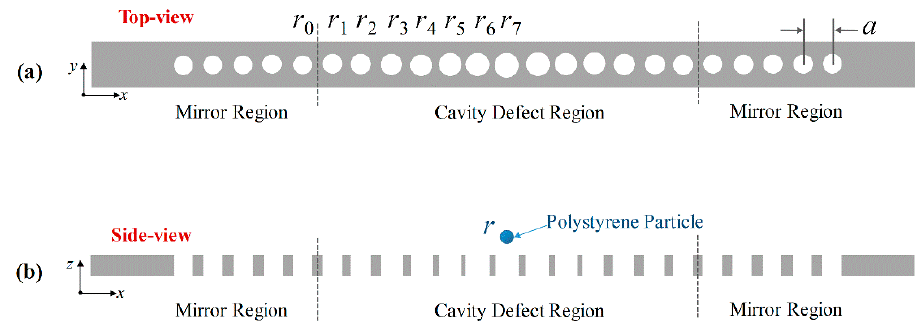
Figure 1. ( a ) Top-view and ( b ) Side-view of the structure of the larger-center-hole nanobeam photonic crystal cavity, above which a polystyrene particle is introduced. The position of the polystyrene particle deviates from the center of the largest hole of the cavity in the x direction is denoted as ∆ x . The distance between the center of the polystyrene particle and the top surface of the nanobeam cavity in the z direction is denoted as ∆ z .